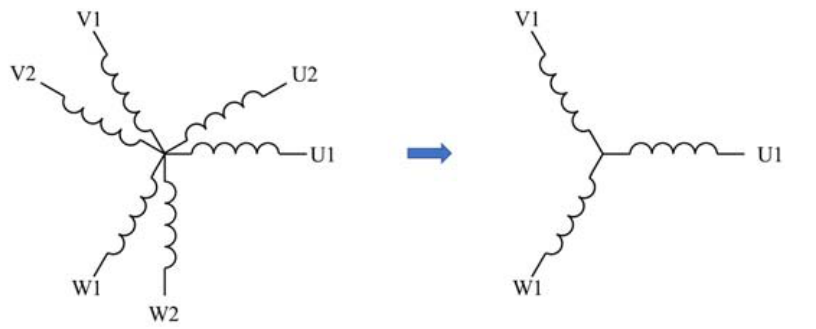
Figure 1. Phase switching from six to three phases.